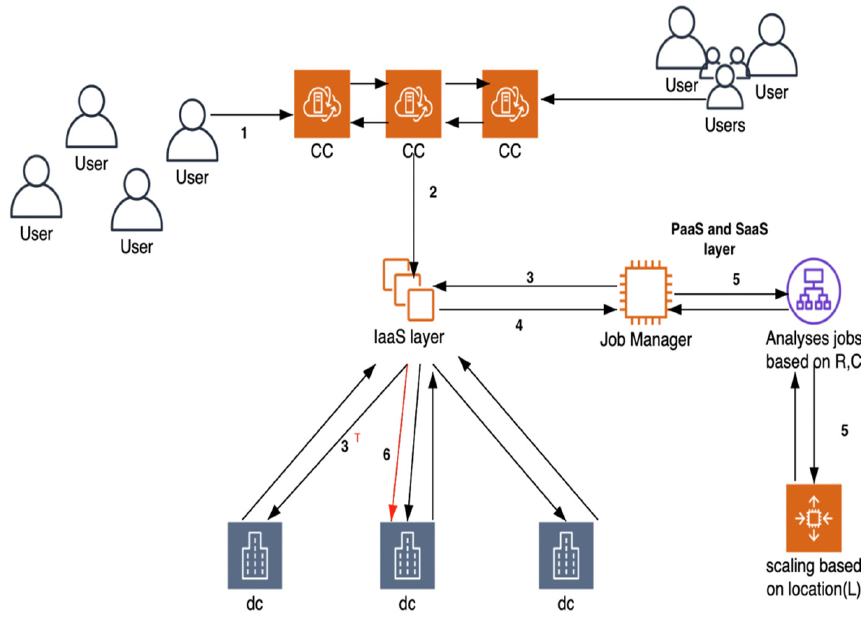
Figure 2. Allocation process at the preliminary allocation.